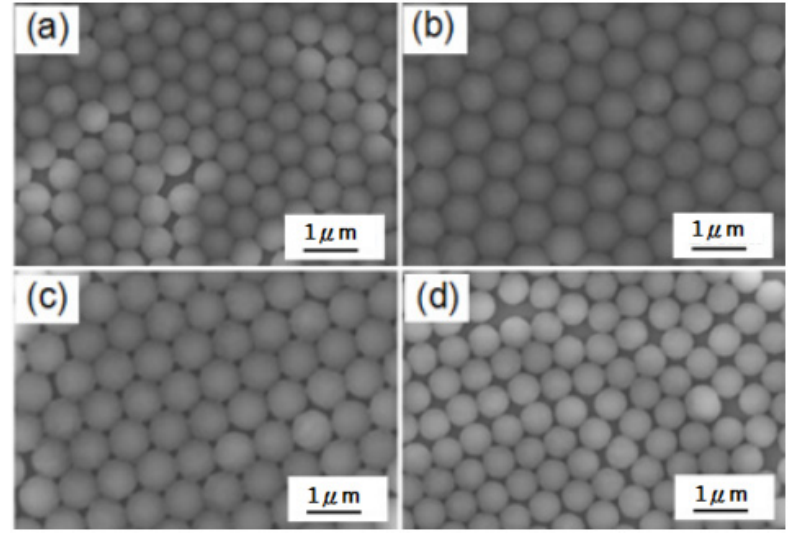
Figure 5. SEM images of self-assembly PS nanosphere masks fabricated with different one-side lifting angles of substrates. The angles used were ( a ) 0°; ( b ) 5°; ( c ) 10°; and ( d ) 15°.